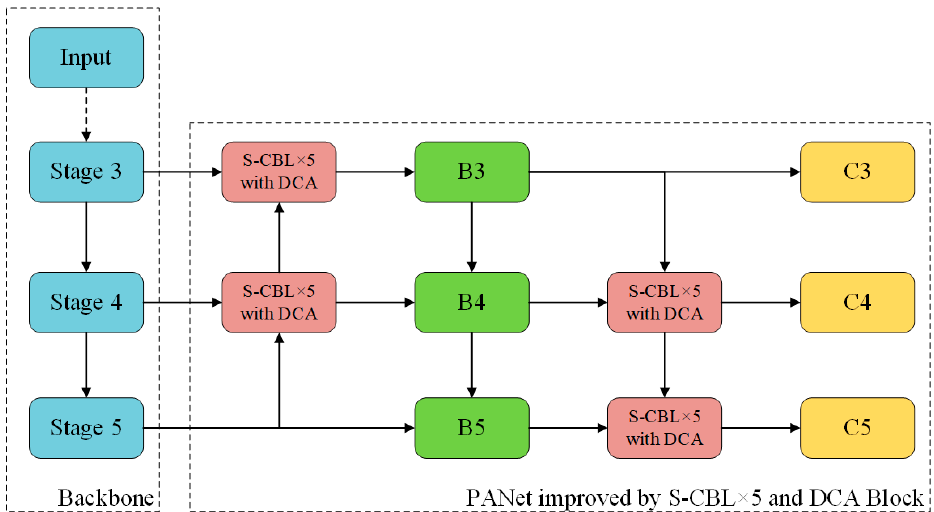
Figure 7. The structure of the improved PANet.